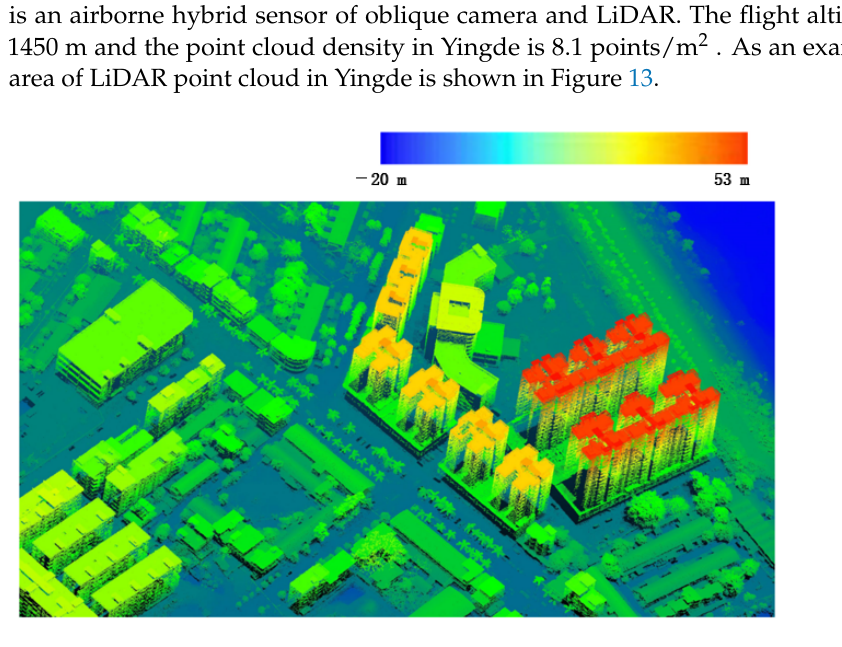
Figure 13. A small area of LiDAR point cloud in